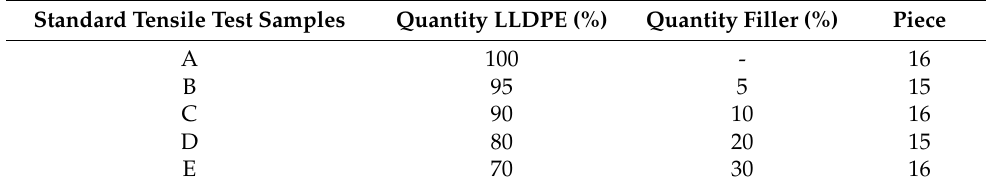
Table 1. The amounts and the quantities of filler by weight included in the polyethylene matrix specimens exposed to gamma radiation. LLDPE (low density linear polyethylene).